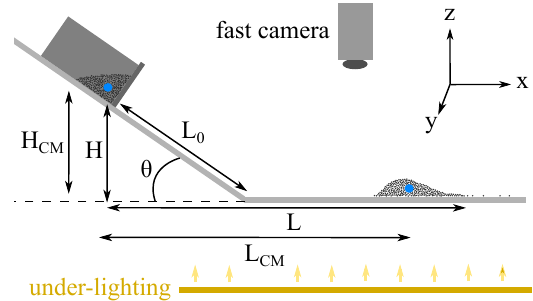
Figure 1. Schematic of experimental setup. The grains are re- leased from a rectangular box by a sliding sluice gate at the front. The released grains slide down a flat glass plate inclined at an an- gle θ and eventually come to rest on a level flat glass plate. The motion and final position of the grains are observed with a fast camera. By illuminating the grains from below and calibrating the transmission intensity, the height distribution and thus center of mass can be accurately determined. The large (blue) dot indi- cates the initial and final center of mass positions with a di ff er- ence in height given by H CM , a di ff erence in horizontal distance given by L CM . The di ff erence in height and horizontal position for the front position is given by H and L